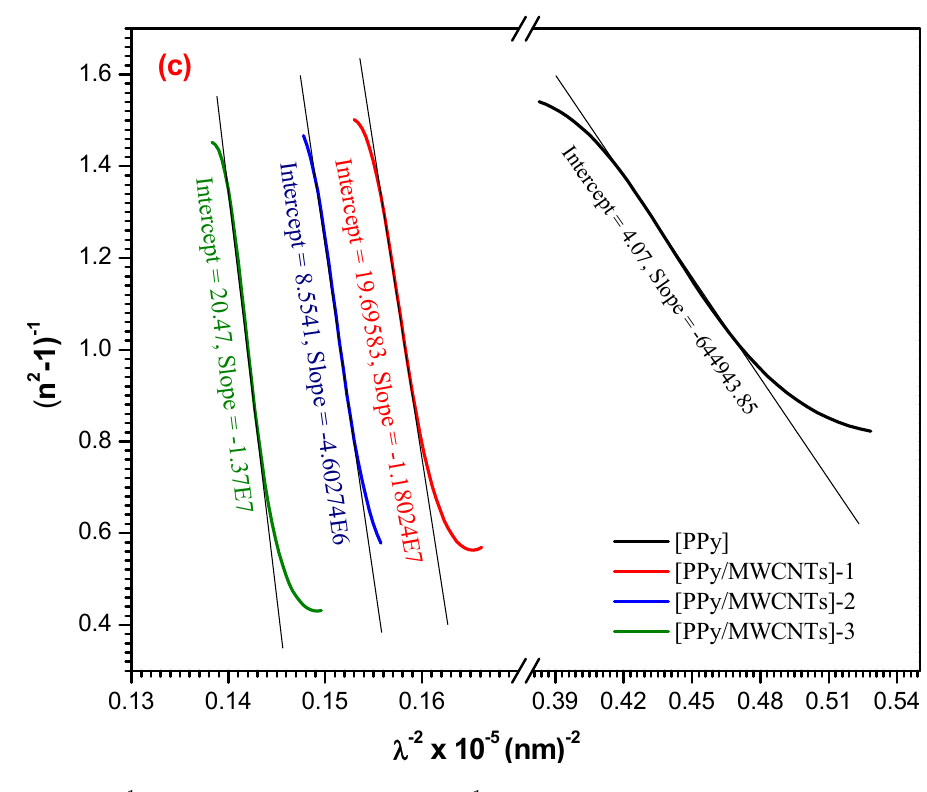
(cid:0) (cid:1) − 1 n 2 − 1 vs. λ − 2 plots for PPy and different types of PPy/MWCNTs